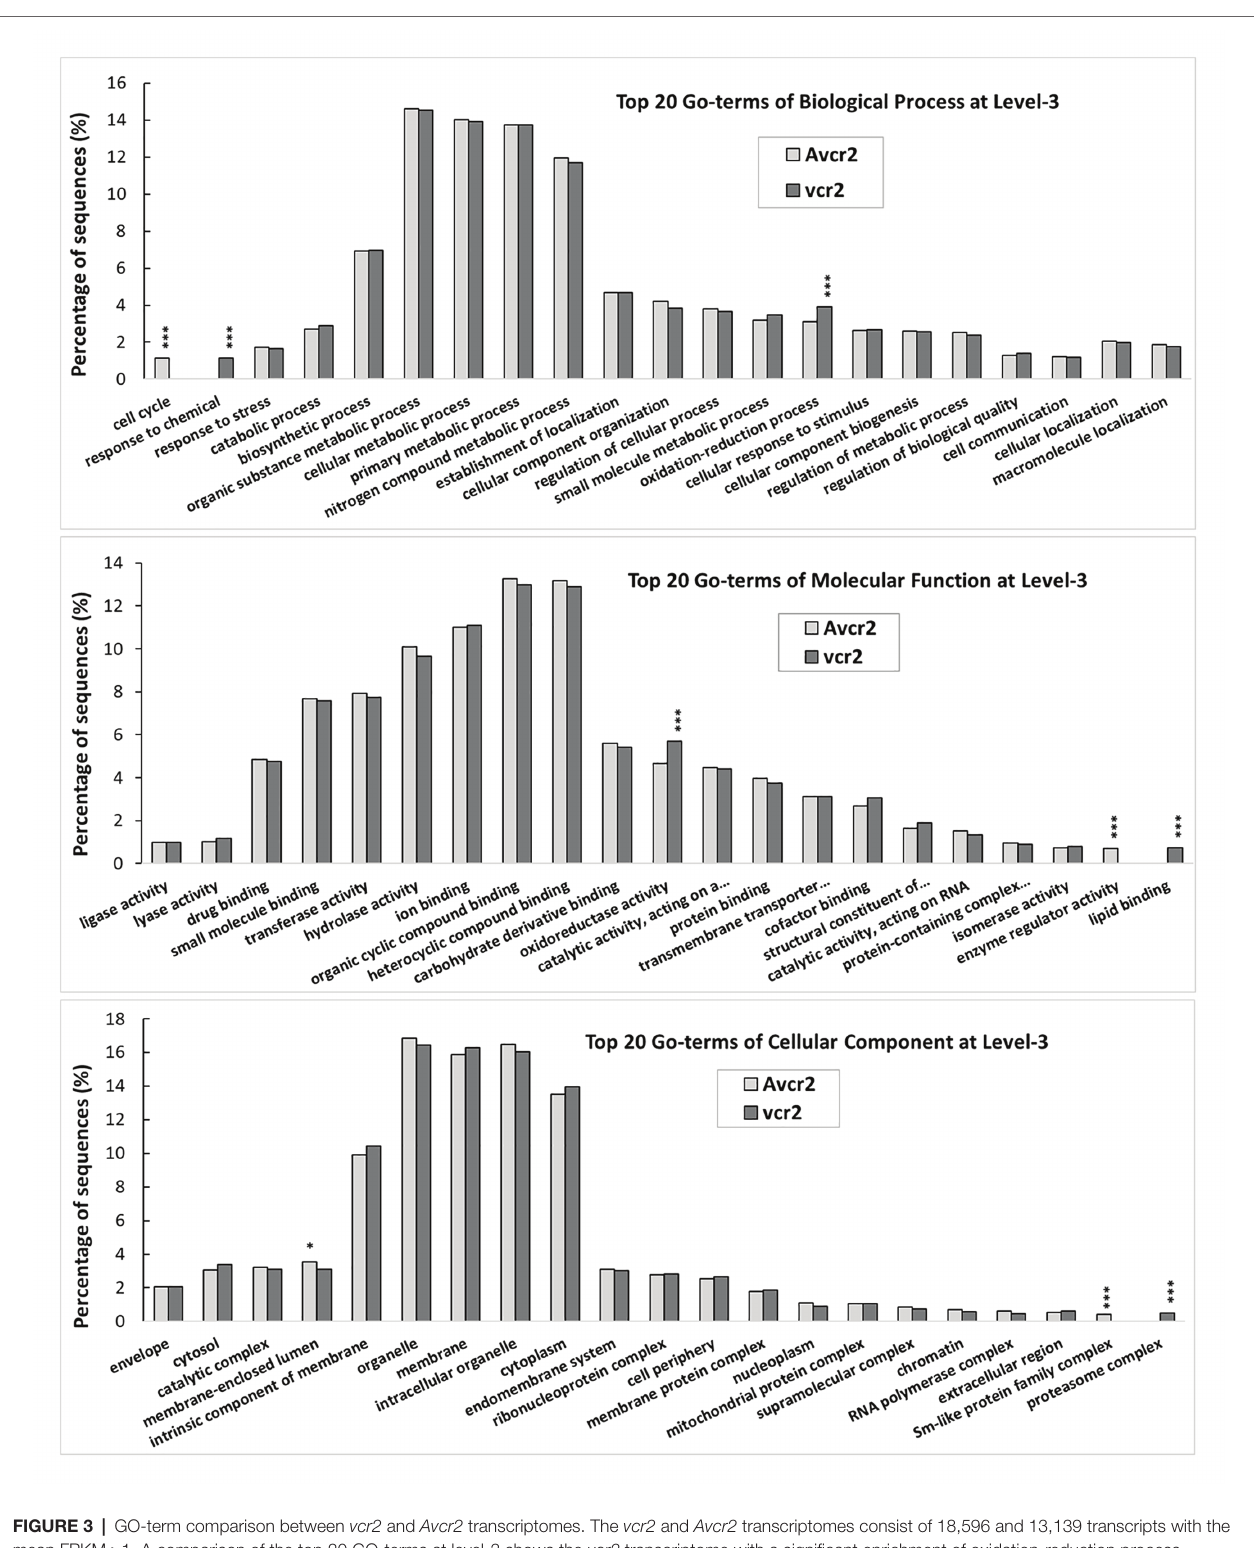
FIGURE 3 | GO-term comparison between vcr2 and Avcr2 transcriptomes. The vcr2 and Avcr2 transcriptomes consist of 18,596 and 13,139 transcripts with the mean FPKM >1. A comparison of the top 20 GO-terms at level-3 shows the vcr2 transcriptome with a significant enrichment of oxidation-reduction process (GO:0055114), response to chemical (GO:0042221), oxidoreductase activity (GO:0016491), lipid binding (GO:0008289), and proteasome complex (GO:0000502) while the Avcr2 transcriptome with enrichment of cell cycle (GO:0007049), enzyme regulator activity (GO:0030234), membrane-enclosed lumen (GO:0031974), Sm-like protein family complex (GO:0120114). One and three stars indicate chi-square test p < 0.05 and 0.001,